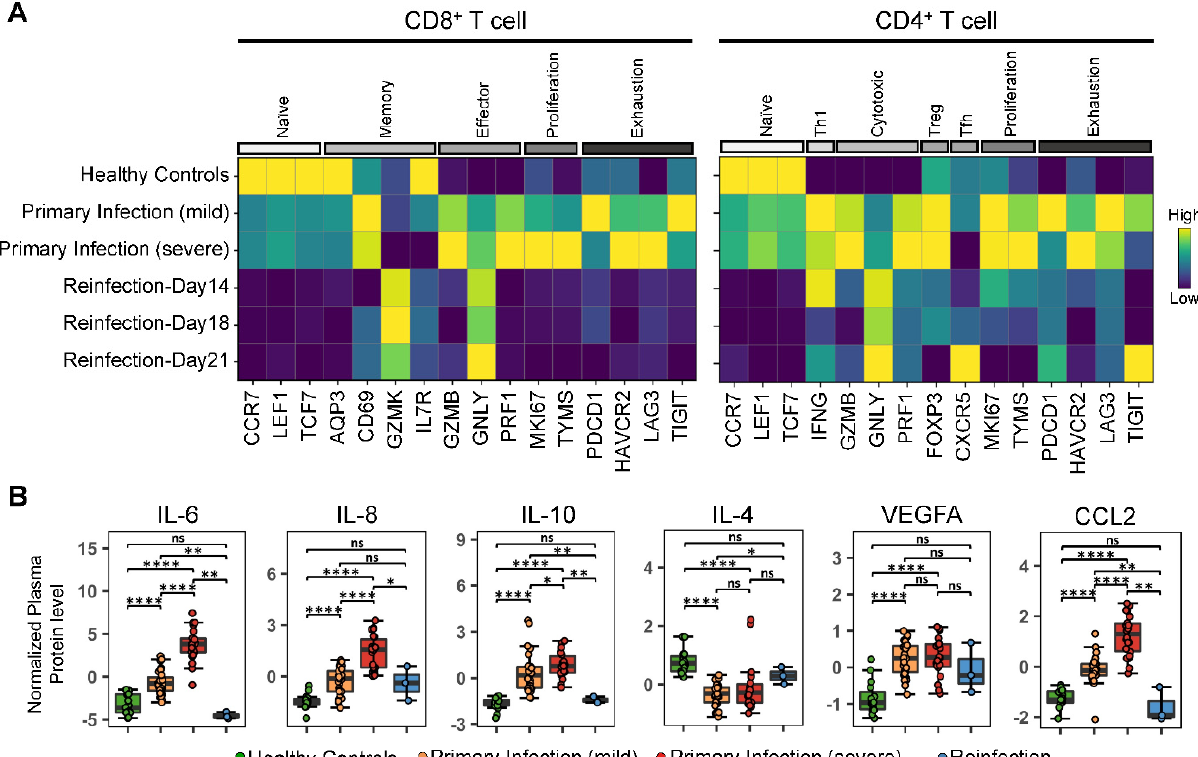
Figure 5. T cell phenotypes and plasma proteins. T cell phenotypes are compared between the reinfection patient (InCoV139), 26 representative primary infection patients sampled at 2 time points with mild infection (n = 29 samples) or severe infection (n = 21 samples), as well as 6 healthy controls sampled prior to the SARS-CoV-2 pandemic (n = 6 samples). For the primary infection cohort, severity at the time of sample draw was determined by applying the World Health Organization (WHO) ordinal scale score (see supplement methods) as follows: mild = WHO 1–4, severe = WHO 5–7. Panel ( A ): Heatmaps showing the normalized expression of select phenotype-specific representative gene expression in CD8+ and CD4+ T cells for healthy controls (top row), primary infection patients (rows 2–3) and the reinfection patient at different time points (bottom 3 rows). The heatmap color describes relative abundance. Panel ( B ): Box plots of select plasma protein levels from the same healthy, COVID-19 patients and the reinfected individual (all 3 time points). Plasma proteins are chosen as representative markers of inflammation (IL-6), stimulatory (IL-8), regulatory (IL-10, IL-4), and chemoattractive (CCL2) cytokines. We also included VEGF level for comparison given the key role of this marker in hypoxia. Significance is indicated by: (ns = not significant, * p < 0.05, ** p < 0.01, **** p <